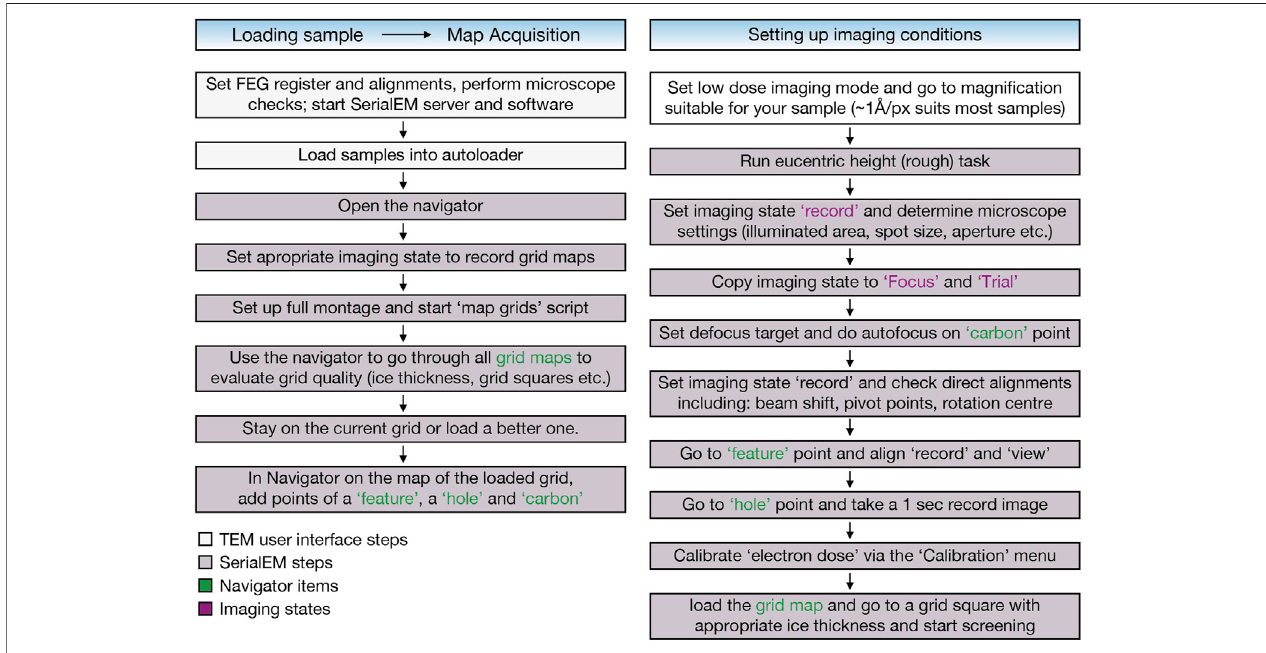
FIGURE 2 | EM sample screening work fl ow using the SerialEM software (Mastronarde, 2005) includes automatic grid map acquisition of all loaded grids using the “ map grids ” script (https://serialemscripts.nexperion.net) followed by setting up imaging conditions for visual inspection of the